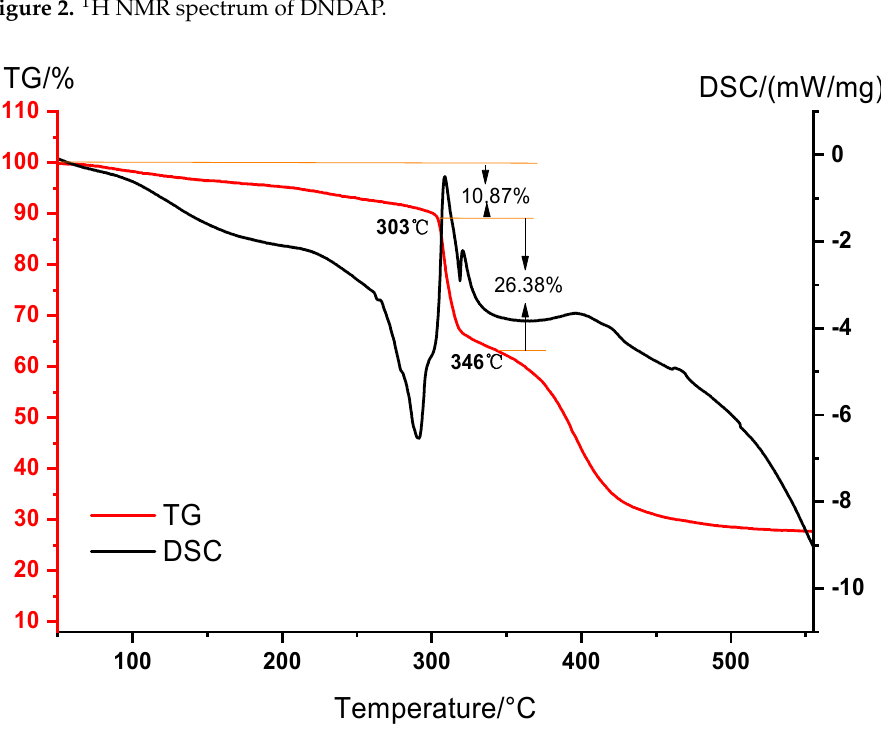
Figure 3. TGA-DSC analysis of DNDAP.